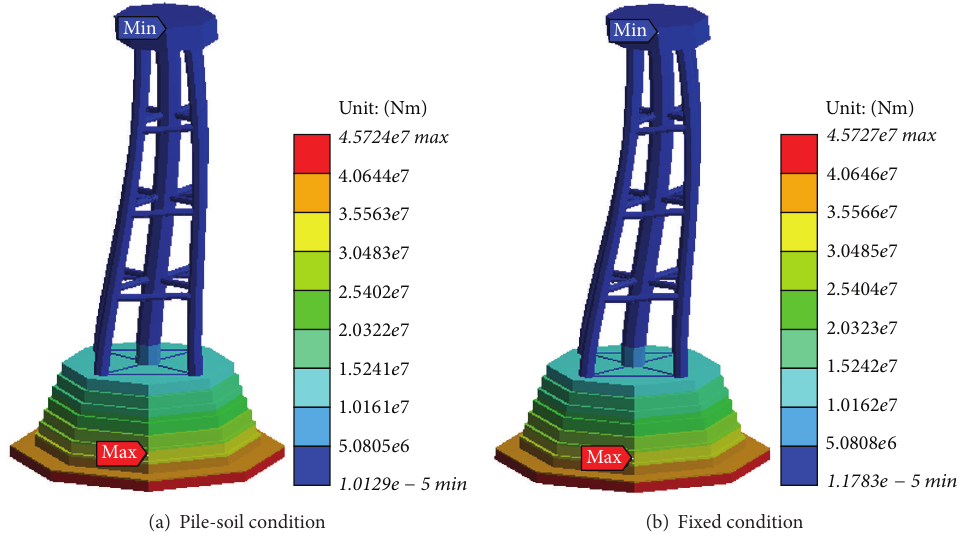
Figure 14: Comparison of bending moments with irregular wave at